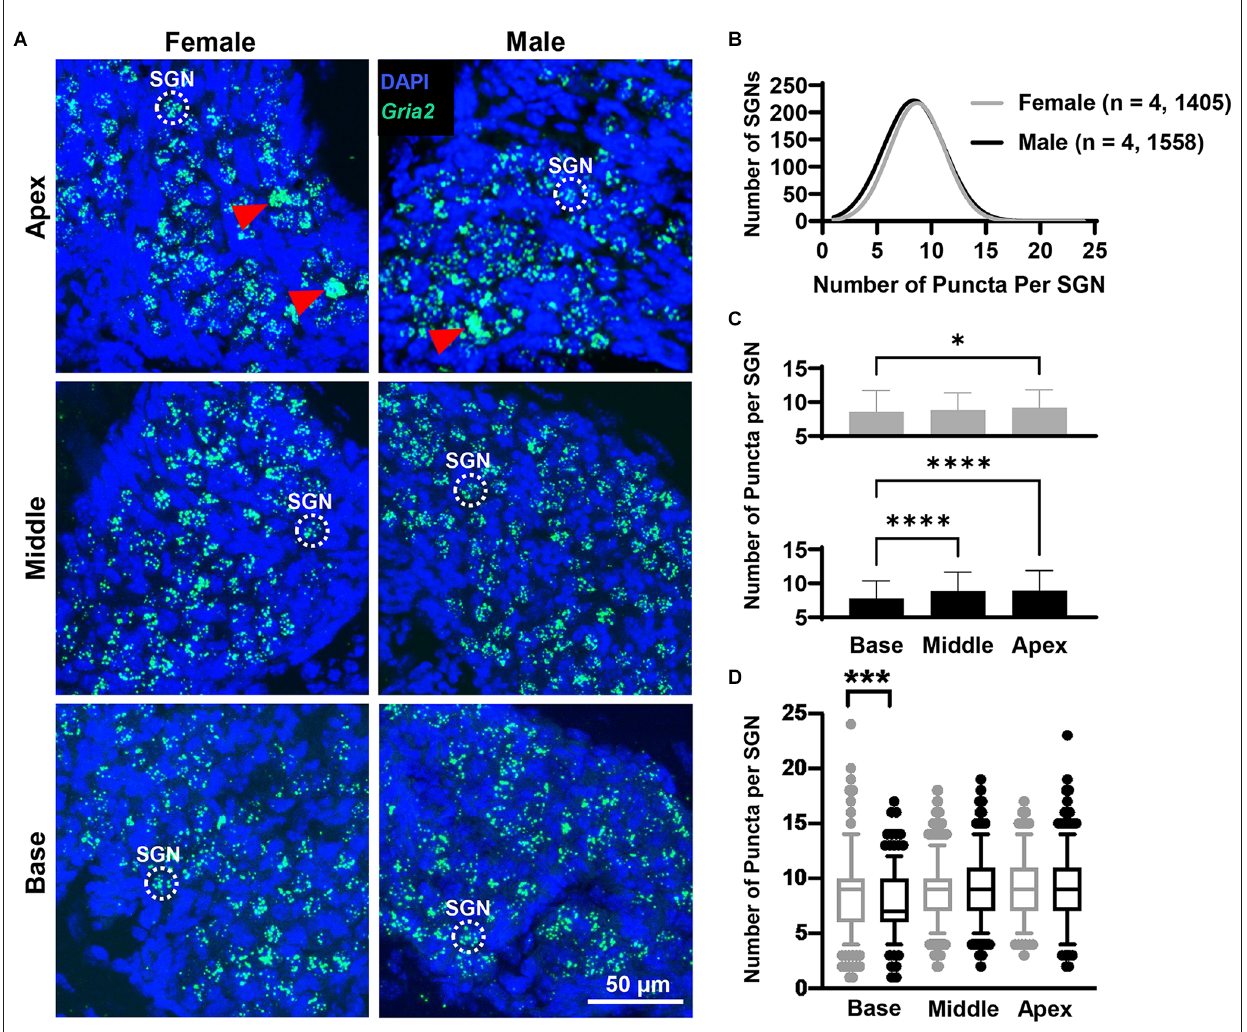
FIGURE3 Gria2 mRNA counts analyzed by cochlear region and sex. (A) Representative fluorescent confocal stack of images of Gria2 (green) and DAPI (blue) in the basal middle, and apical cochlea turns for females and males. Red arrowheads point to SGNs that were excluded due to puncta clustering. (B) Histogram representing the distribution of Gria2 mRNA counts in female (gray line) and male (black line) mice throughout the entire cochlea. Numbers in parentheses indicate the number of mice, followed by the total number of SGNs. (C) Bars show the mean Gria2 mRNA puncta on different cochlea turns on SGNs of female (gray bars, top) and male (black bars, bottom) mice. Error bars represent ± SD. (D) Whisker plots of Gria2 mRNA puncta on different cochlea turns on SGNs of females (gray) and males (black). Females had more Gria2 mRNA in the basal turn compared to males. Whiskers display the 5 and 95 percentiles. Samples consisted of the total number of SGNs for which Gria2 puncta were counted in females and males. See Table 2 for sample sizes by region. Independent samples t -test, ∗ p < 0.05, *** p < 0.0005, ∗∗∗∗ p < 0.0001, see “Results” Section for specific p